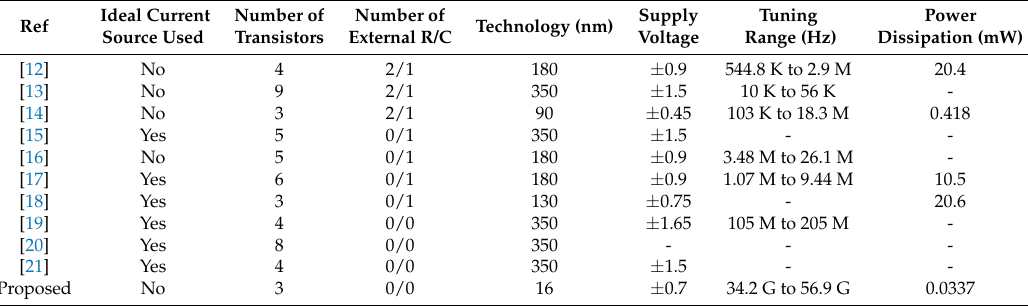
Table 2. Comparison of AOTAPF with other reported